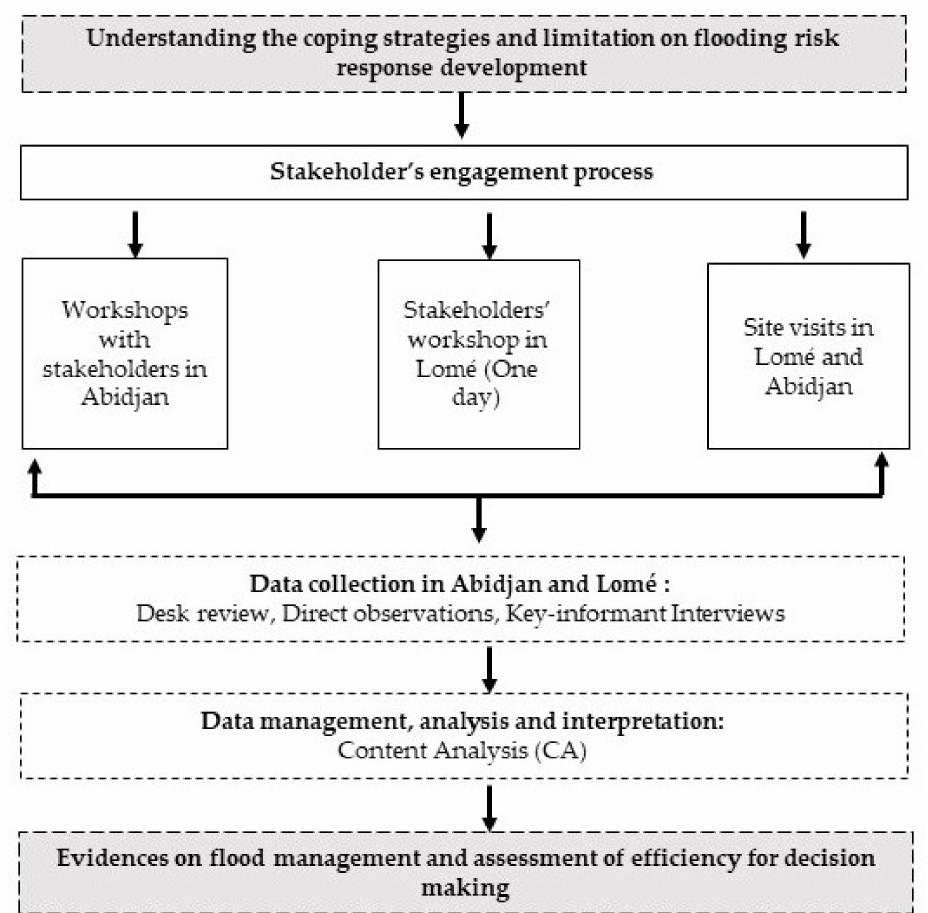
Figure 2. Research framework for understanding data collection process in the